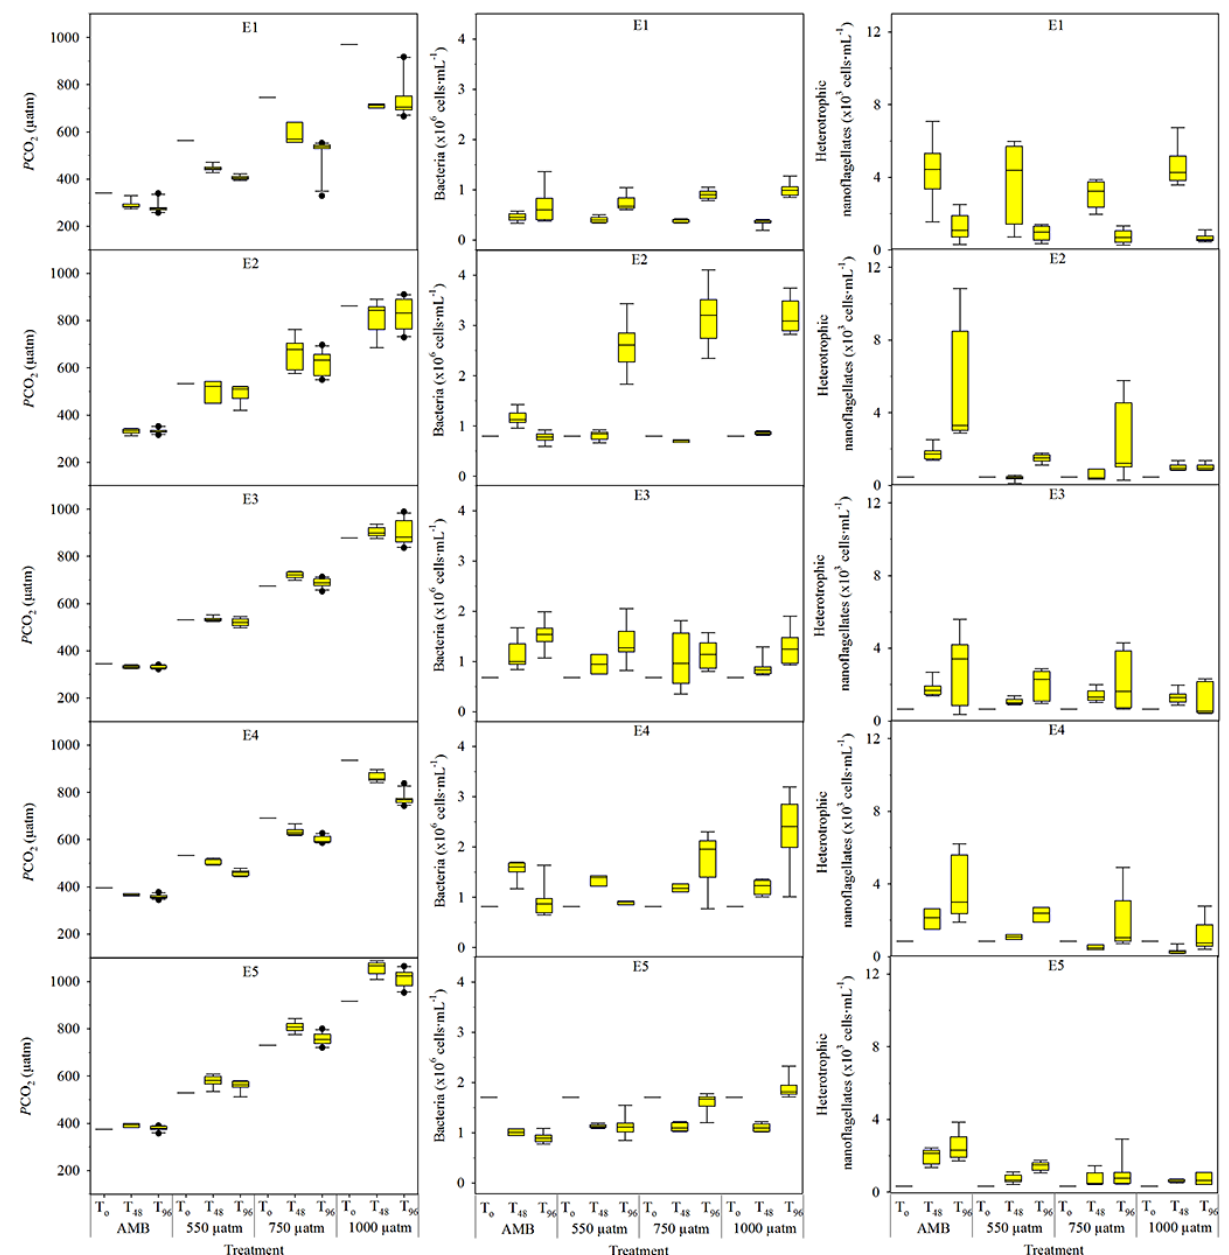
Figure 8. P CO 2 , total bacterial abundance and the abundance of heterotrophic nanoflagellates derived from bioassay experiments (E1–5) for each treatment and time point. Treatment labels represent the initial intended P CO 2